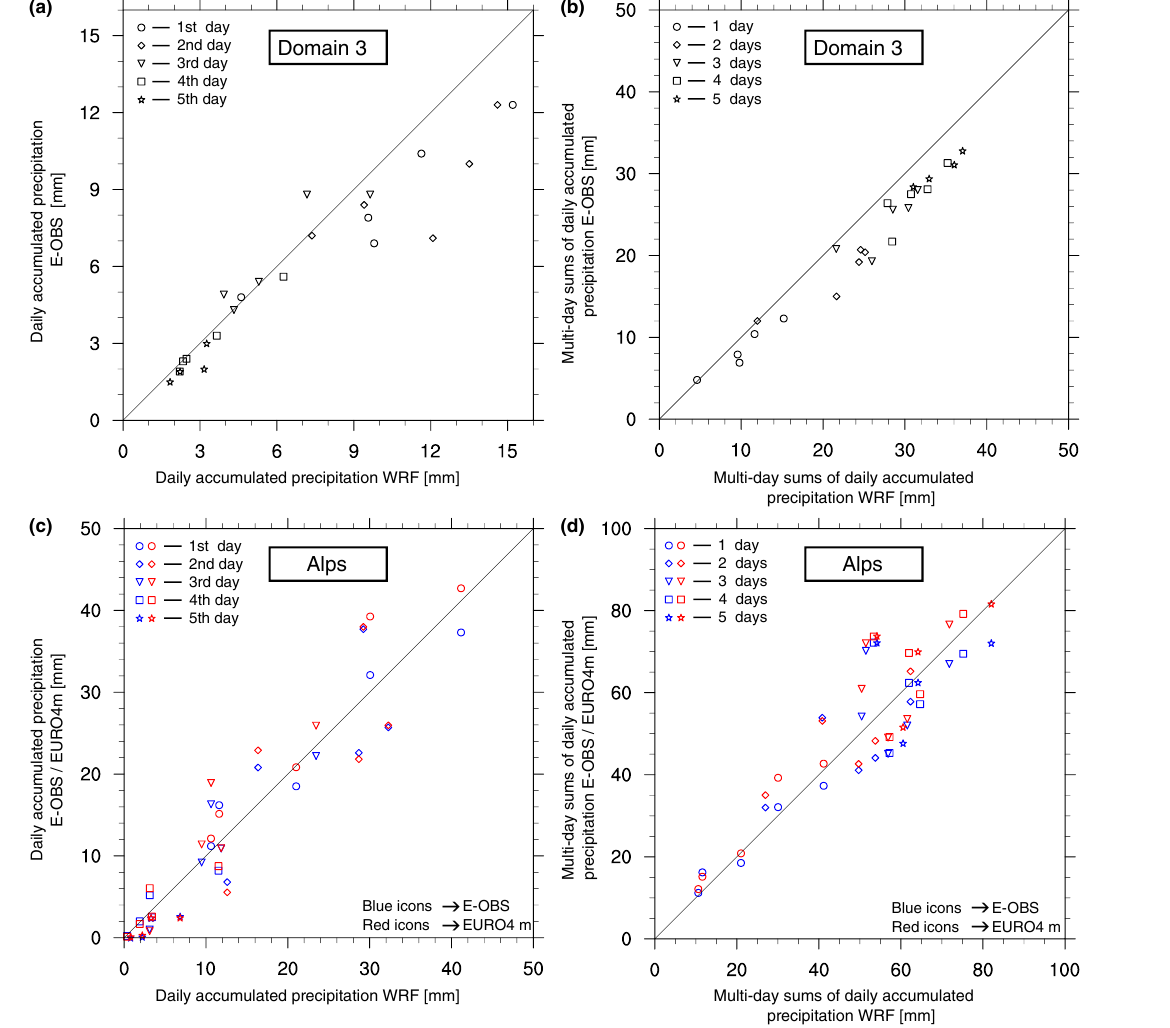
Figure 2. The left column shows the daily accumulated precipitation (mm) obtained by observations plotted against the precipitation obtained by WRF for (a) domain 3 and (c) the Alps (“Alps” box in Fig. 1) for each of the 5 days of the five different Vb events. The right column depicts the multi-day sums of daily accumulated precipitation (mm) for 1 to 5 days for the observations against the multi-day sums obtained by the WRF simulations for (b) domain 3 and (d) the Alps for each of the five Vb events. The upper row uses E-OBS as an observational data set, while the bottom row depicts E-OBS (blue icons) and EURO4m-APGD (red icons) as observational data